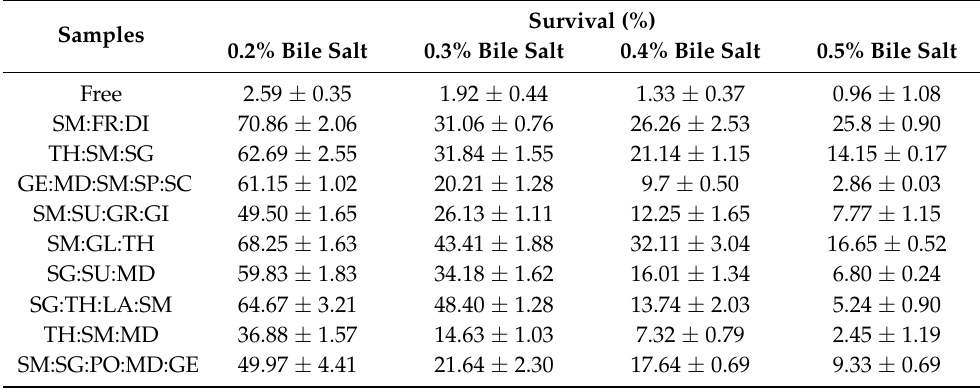
Table 3. Tolerance of microencapsulated LR-LFCA to bile salts.